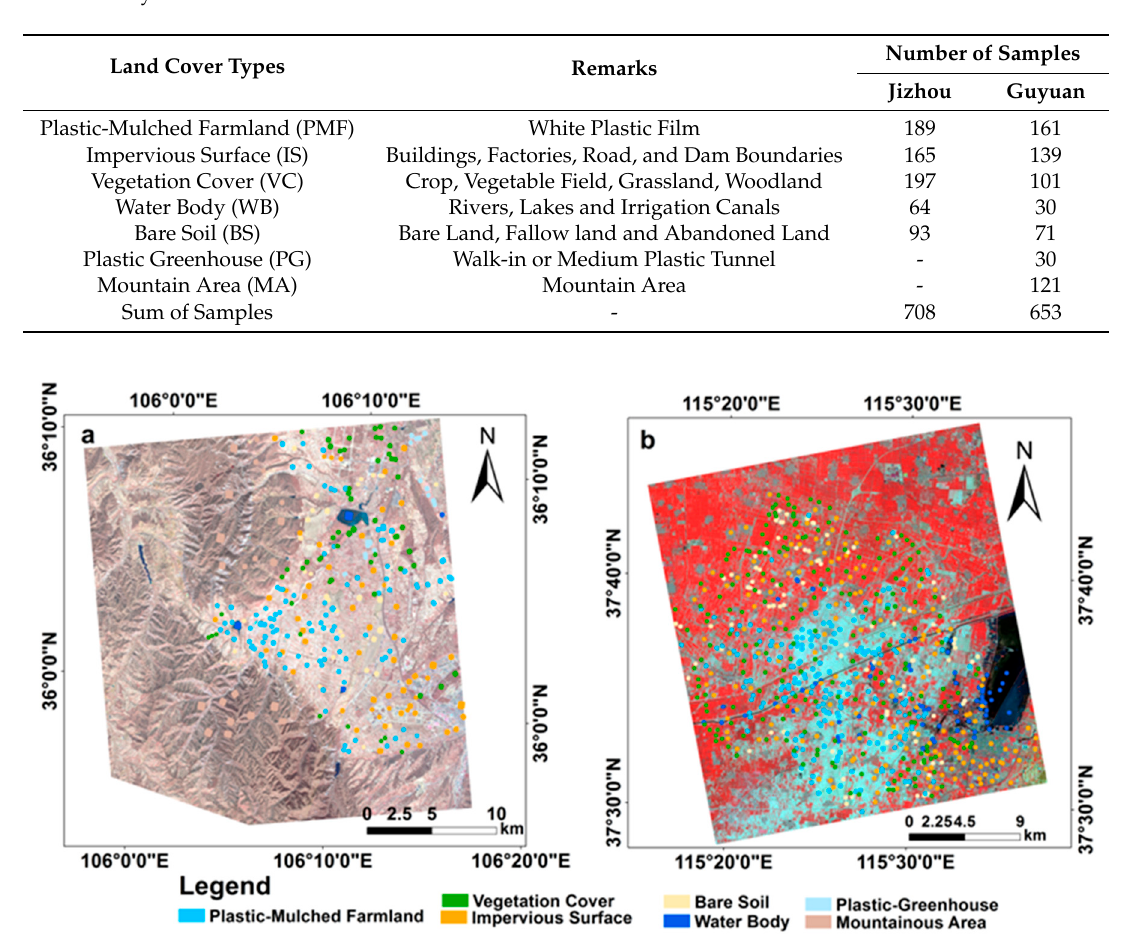
Figure 2. The distribution of collected samples: ( a ) samples of land cover types in Guyuan; ( b ) samples of land cover types in Jizhou; two scenes of GF-1 images are displayed in false color composition (R: NIR, G: red, B: green).